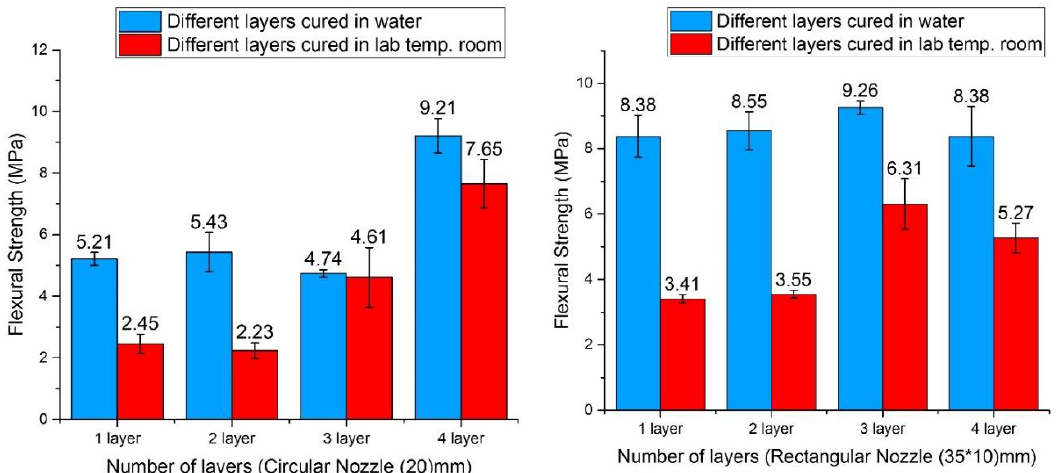
Figure 22. Flexural strength for the (1,2,3,4) layers of mortar mix for a circular nozzle (20) mm and a rectangular nozzle (35 × 10) mm at air temperature and with water curing.